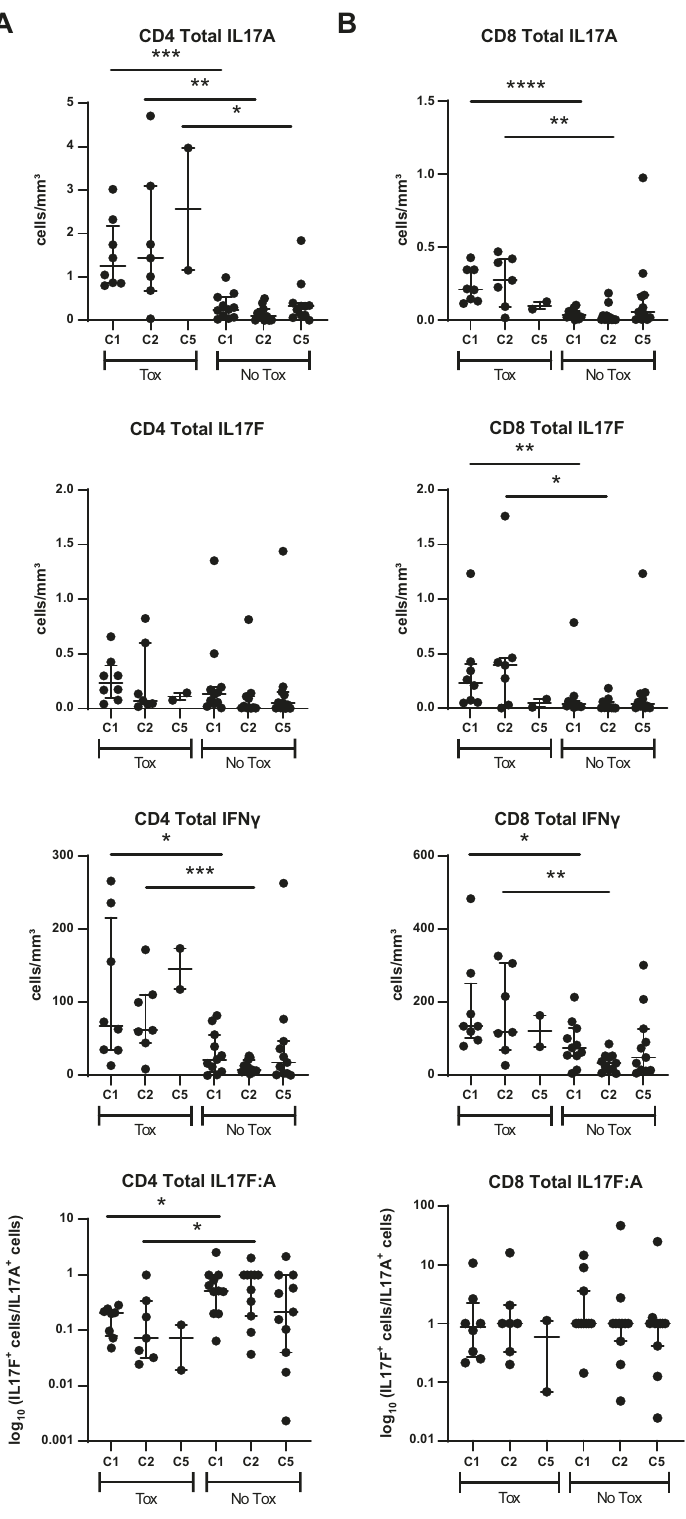
Fig. 2 Intracellular fl ow cytometry measurements of IL-17A, IL-17F and IFN γ in CD4 and CD8 T cells treated with idelalisib. A Absolute number of CD4 T cells positive for the indicated cytokine at C1 (prior to treatment), C2 and C5, comparing patients with early toxicity (Tox) to either delayed or no toxicity (No Tox). The bottom panel is the ratio of IL17F:A. B Absolute number of CD8 T cells positive for the indicated cytokine at C1 (prior to treatment), C2 and C5, comparing patients with early toxicity (Tox) to either delayed or no toxicity (No Tox). The bottom panel is the ratio of IL17F:A. * p ≤ 0.05; ** p ≤ 0.01; *** p ≤ 0.001; **** p ≤